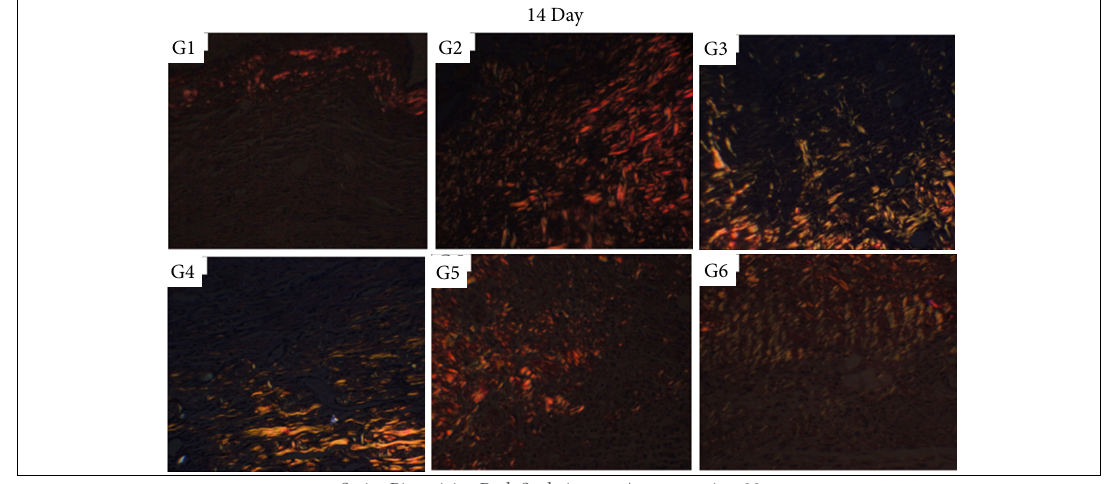
Figure 11 - Collagen fibers deposition in partial thickness burn wounds experimentally induced in Wistar rats and treated with silver-based dressings 14 DAI. Type I collagen fibers are shown in red and type III collagen fibers are shown in